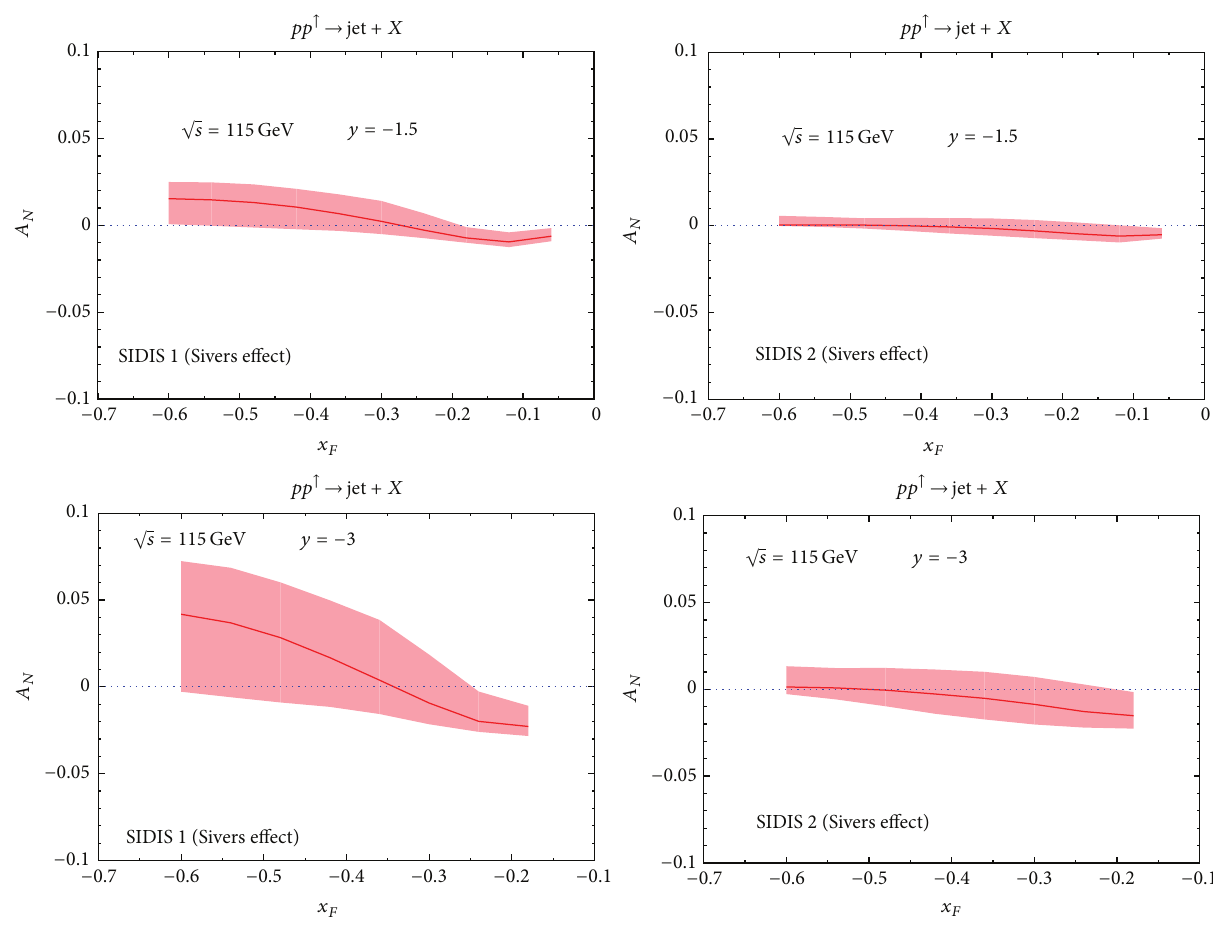
Figure 8: Our theoretical estimates for 𝐴 𝑁 versus 𝑥 𝐹 at √𝑠 = 115 GeV, 𝑦 = − 1 . 5 (upper plots), and 𝑦 = − 3 . 0 (lower plots) for inclusive single jet production in 𝑝𝑝 ↑ → jet 𝑋 processes, computed according to (6) and (7) of the text. Only the Sivers effect contributes. The computation is performed adopting the Sivers functions of [20] (SIDIS 1, left panels) and of [21] (SIDIS 2, right panels). The overall statistical uncertainty band, also shown, is obtained following the procedure described in Appendix A of [21].